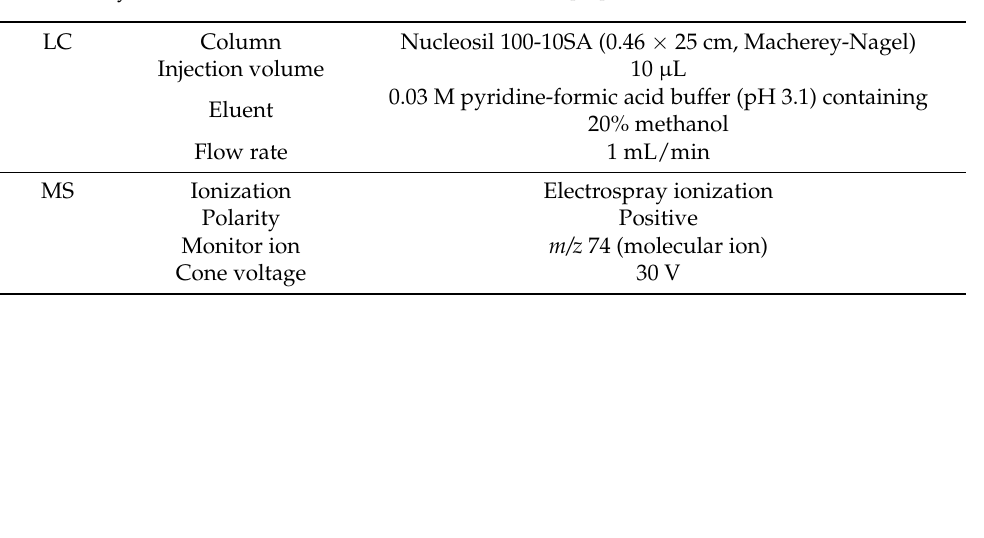
Table 1. Analytical conditions of LC/ESI-MS for tetramine